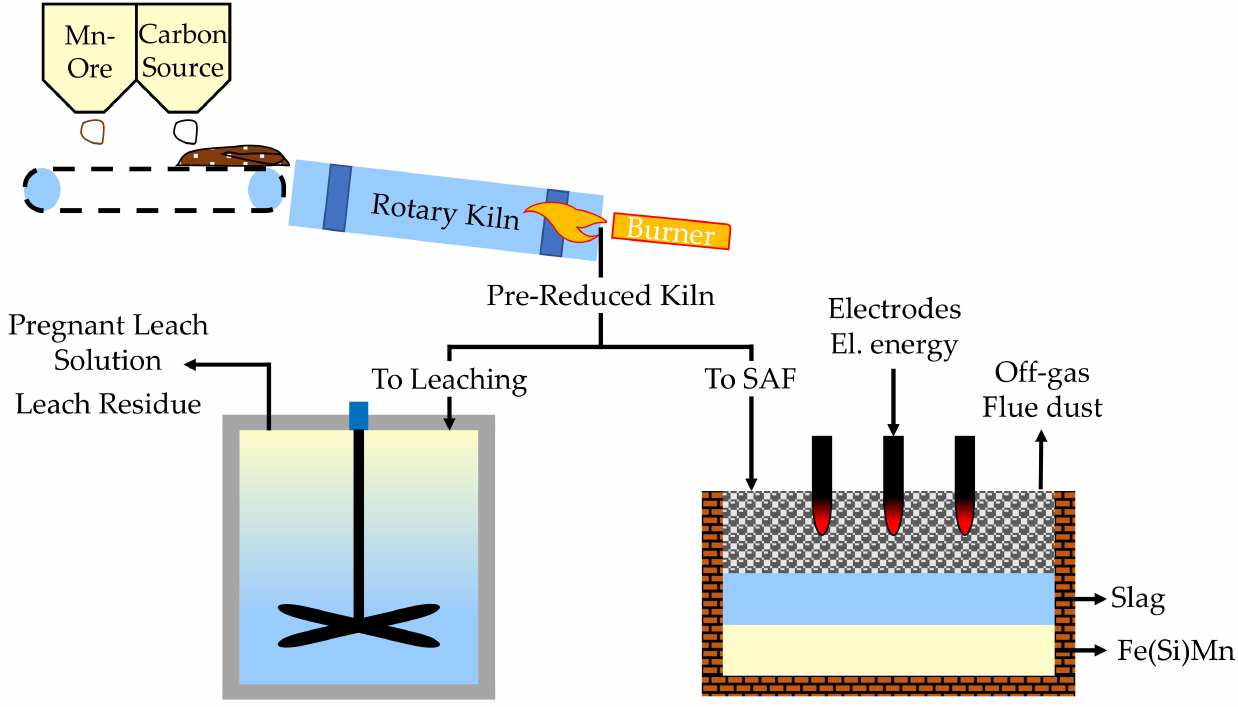
Figure 18. Possible processes to treat pre-reduced manganese